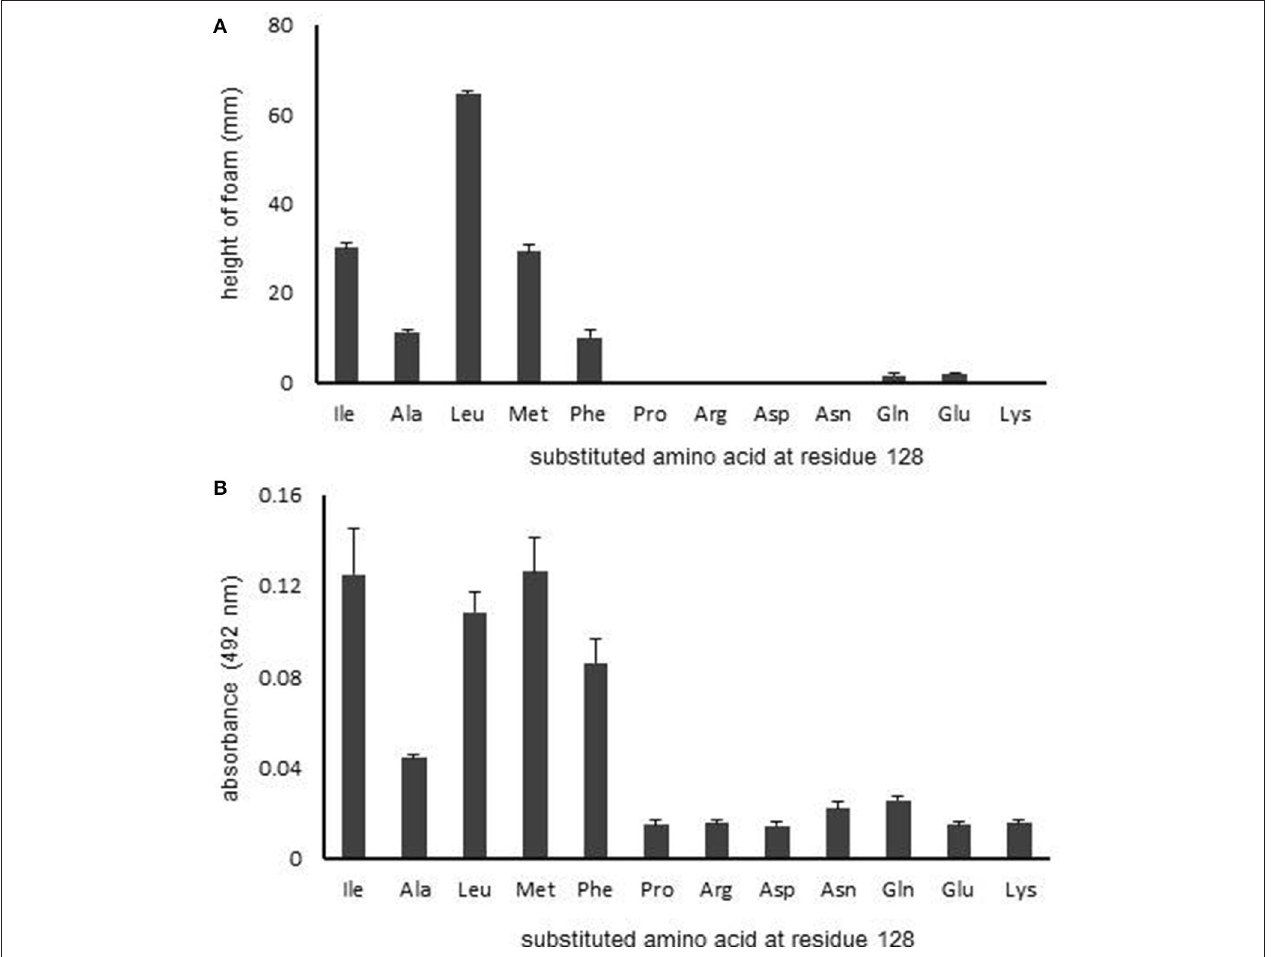
FIGURE 4 | Effect of the characteristics of the amino acid at residue 128 on RpoS activity. (A) HPII activity in rpoS variants was measured by HPII assays. (B) β -Galactosidase activity was measured using spectrophotometry. Mean values are shown ( n = 3). Error bars represent standard deviations. The statistical significance of the differences is tabulated in Tables S4,